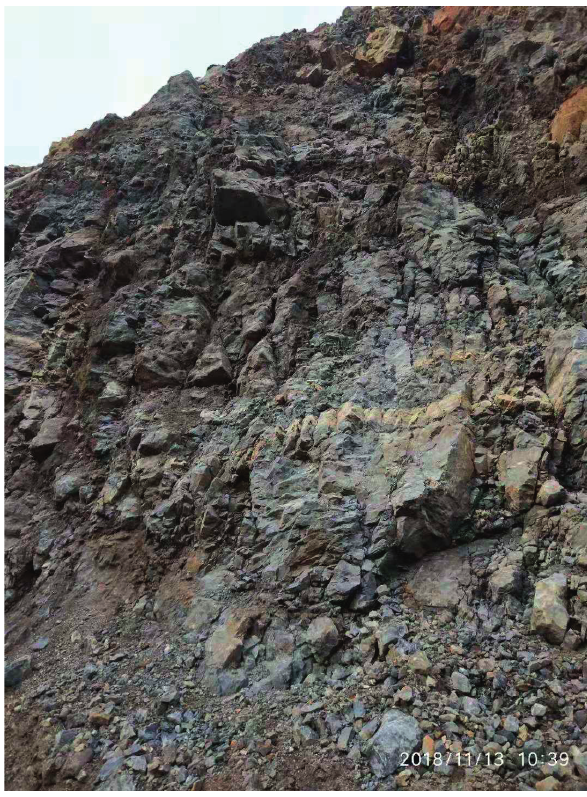
Figure 1: Slope of an open pit